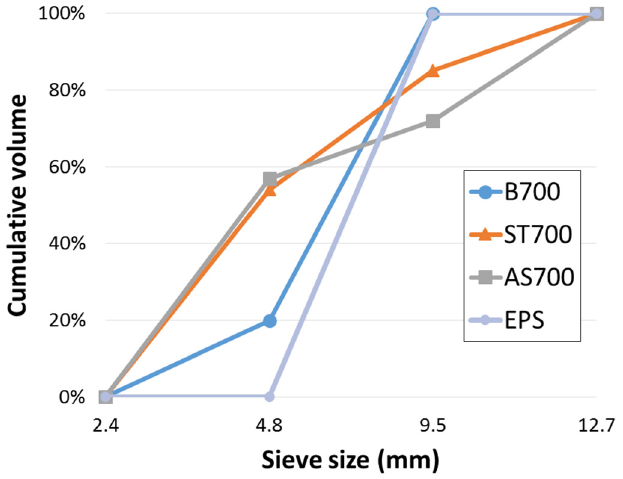
Figure 3. Gradation of lightweight